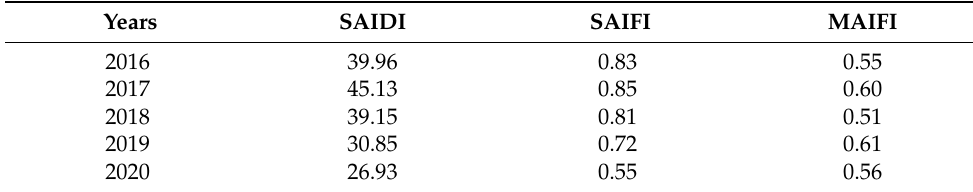
Figure 4. Graph comparison of the types of failures to the number of energy consumption points victims—from 2016 to 2020. Table 1. Energy quality indicators—from 2016 to